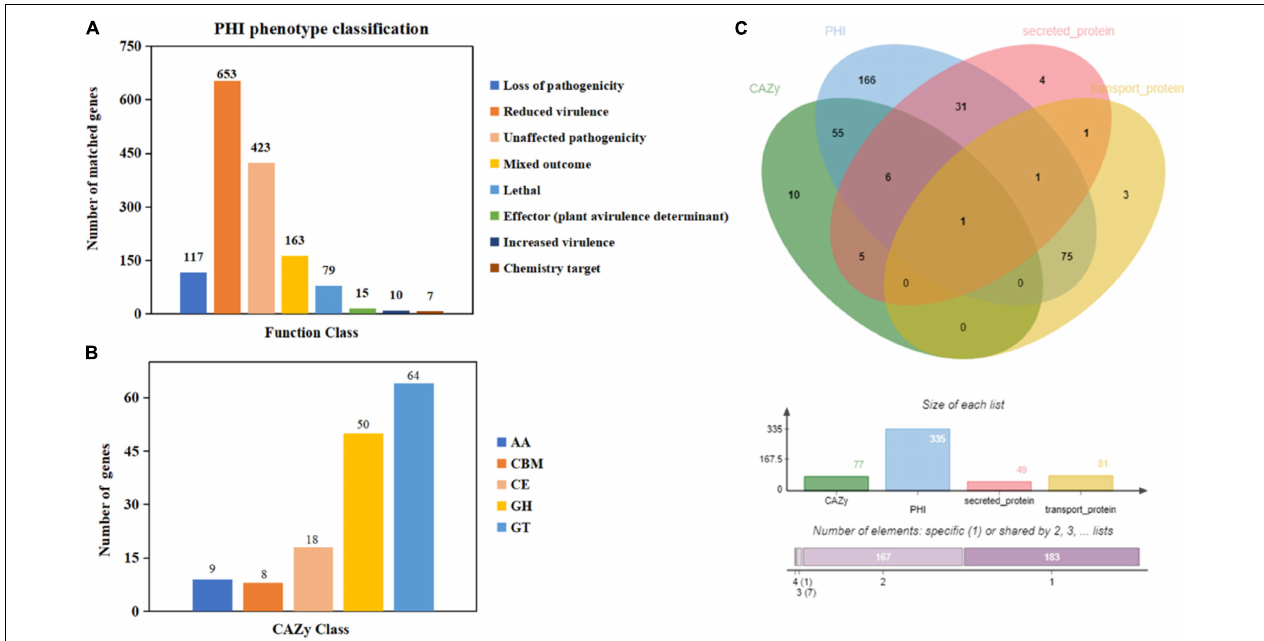
FIGURE 2 | Gene annotation and gene prediction of M. bicuspidata LNES0119. (A) Genes were annotated and classified in the PHI database. Bars in different colors represent different PHI function classes, and lengths represent the number of genes. (B) Genes were annotated and classified in the CAZy database. Bars in different colors represent different CAZy categories, and lengths represent the number of genes. GH, glycoside hydrolase; GT, glycosyltransferase; CE, carbohydrate esterase; AA, auxiliary activity; CBM, carbohydrate-binding module. (C) Venn diagram showing the overlap of PHI-homologs and secretory proteins with transport protein and CAZymes.